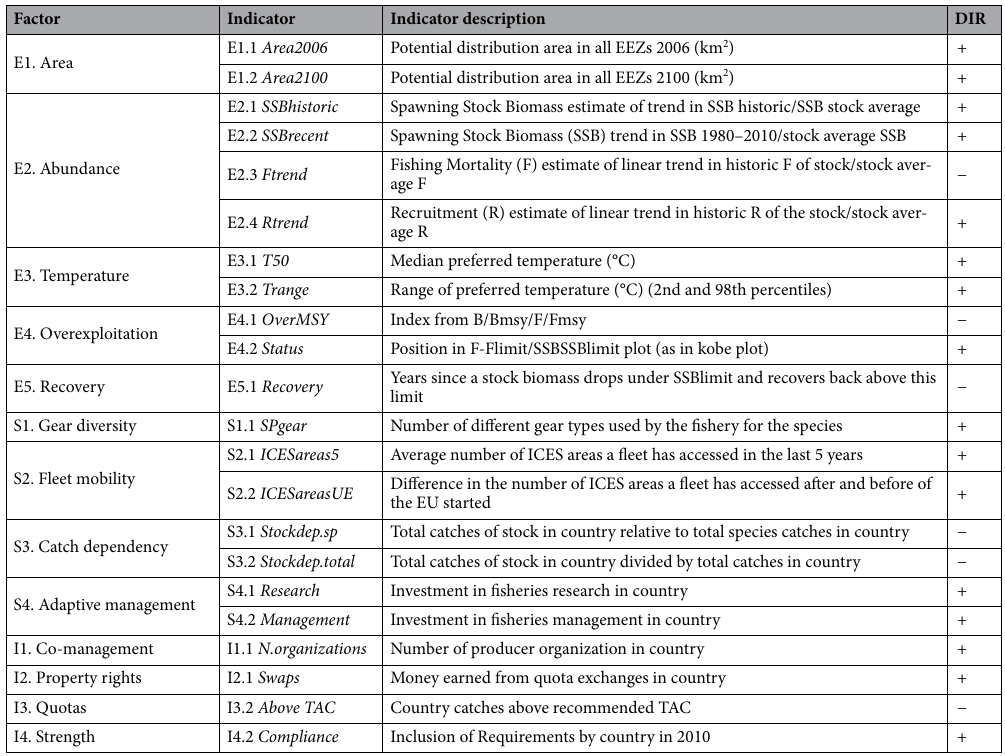
Table 2. List of resilience indicators. The table shows the resilience factors from the literature and the proposed indicators for the analysis, with the direction (DIR) in which they influence resilience. See SI for greater